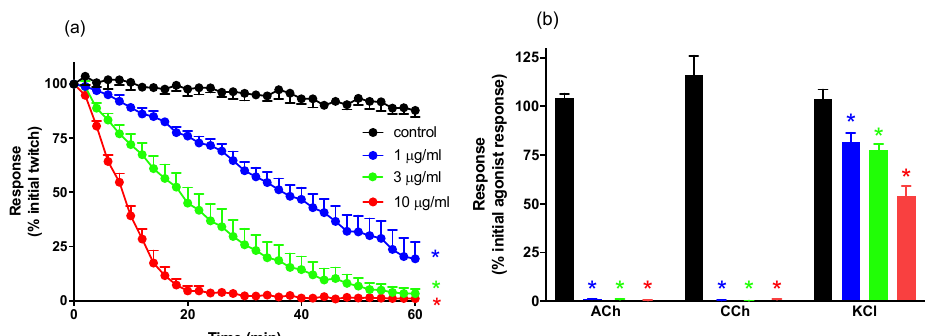
Figure 1. ( a ) The concentration-dependent neurotoxic e ff ects of N. atra venom (1–10 µ g / mL) on indirect twitches of the chick biventer cervicis nerve-muscle (CBCNM) preparation. ( b ) The concentration-dependent e ff ects of N. atra venom (1–10 µ g / mL) on contractile responses to acetylcholine chloride (ACh) (1 mM), carbachol (CCh) (20 µ M), and potassium chloride (KCl) (40 mM) in the CBCNM. * p < 0.05, significantly di ff erent from ( a ) control at 60 min or ( b ) pre-venom response to same agonist. n = 6.